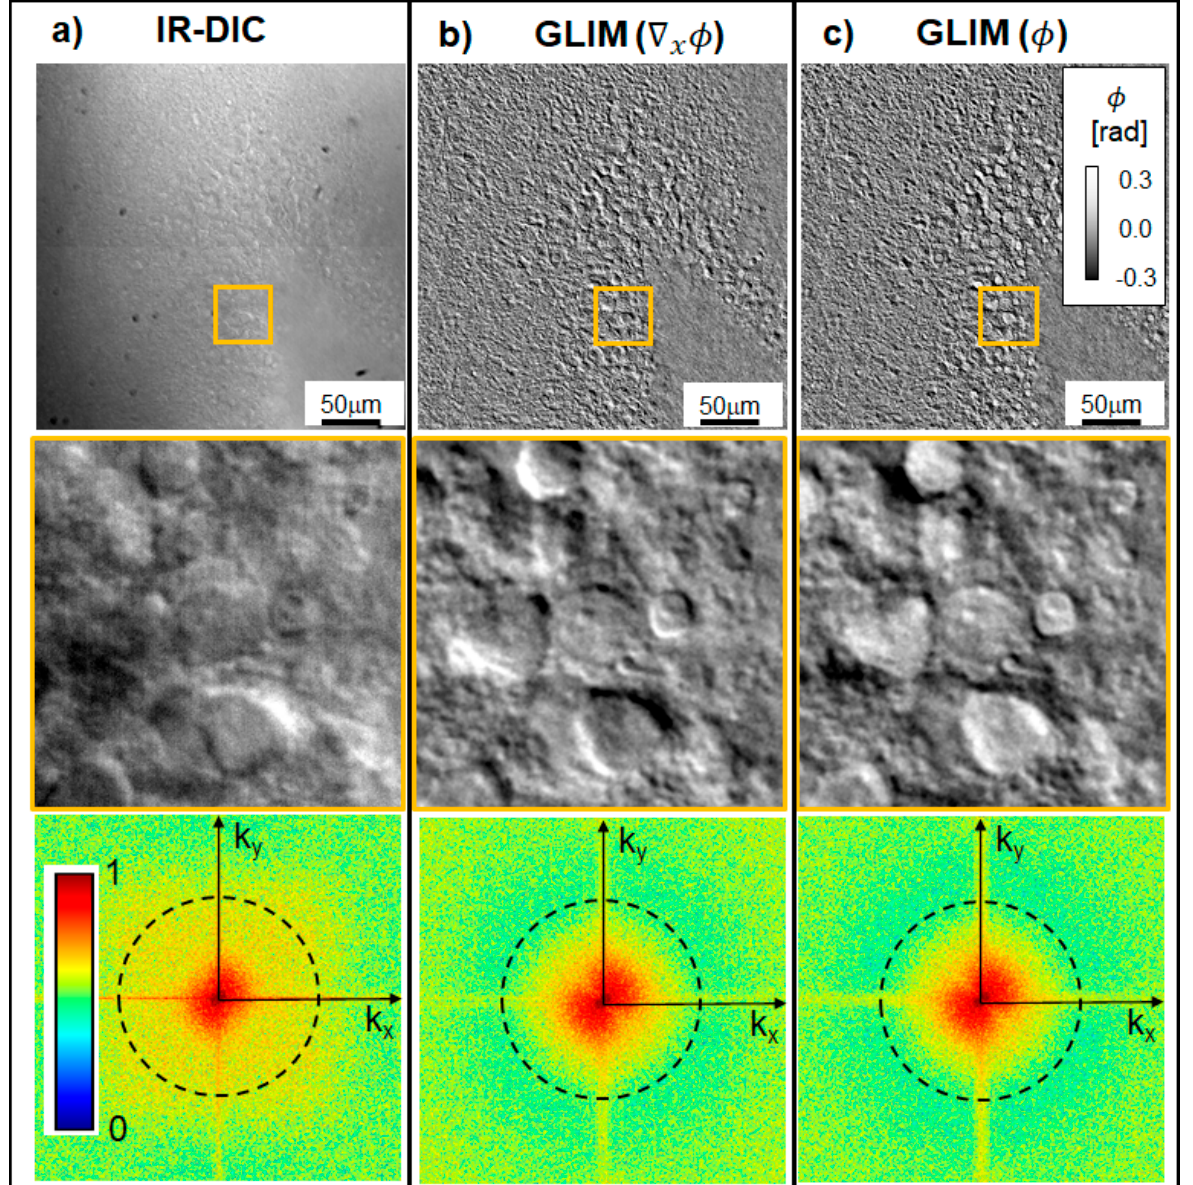
Figure 2. GLIM improves image contrast and resolution of a 300 µ m thick acute brain slice by decoupling phase from unwanted amplitude information . ( a ) Typical DIC image using IR illumi- nation. ( b ) Quantitative phase gradient ( ∇ x φ ) map. ( c ) Quantitative phase image, φ , obtained by Hilbert transform integration. Orange boxes depict zoomed-in regions of interest in the granular layer of the dentate gyrus (DG). The bottom row shows the spatial power spectra associated with the respective zoomed-in images. The DIC image is characterized by a narrower power spectrum due to the scattering background noise corrupting the high-frequency range. As a result, the DG apex, cellular and subcellular structures are more clearly visible in GLIM. The dash rings represent the diffraction limit (40 × /0.75NA objective). The power spectra are plotted in logarithmic scale, normalized to unit